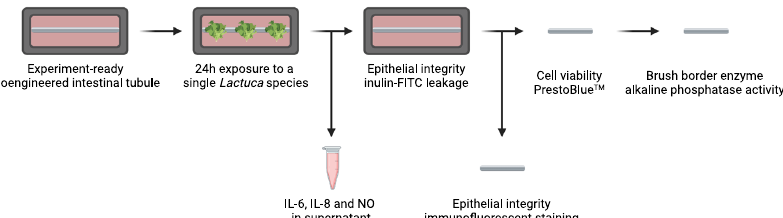
Fig. 1 Schematic representation of the experimental procedure. Bioengineered intestinal tubules were exposed to crude extracts from Lactuca for 24 h in the cell cultivation medium. The supernatant was collected to assess interleukin (IL)-6, IL-8, and nitric oxide (NO) content. The epithelial integrity was determined after removing the supernatant using the inulin-FITC leakage test. After removing the hollow fi ber membrane from the chamber, the tubule was assessed for epithelial integrity via immuno fl uorescent staining or alkaline phosphatase activity and cell viability. Created with BioRender, license